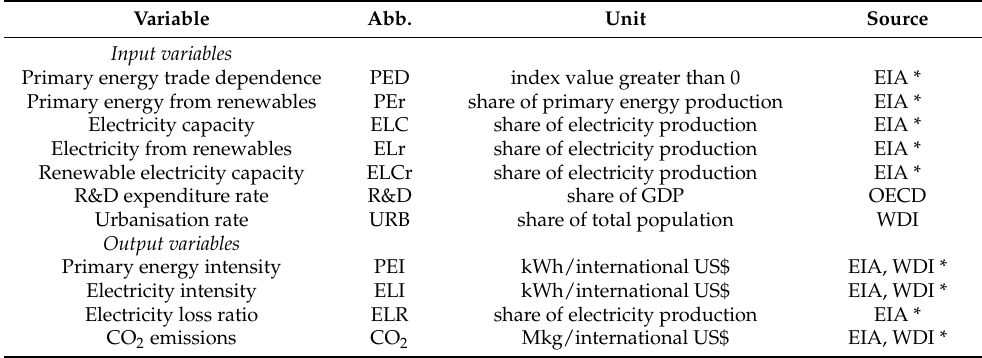
Table A1. Definition of variables.